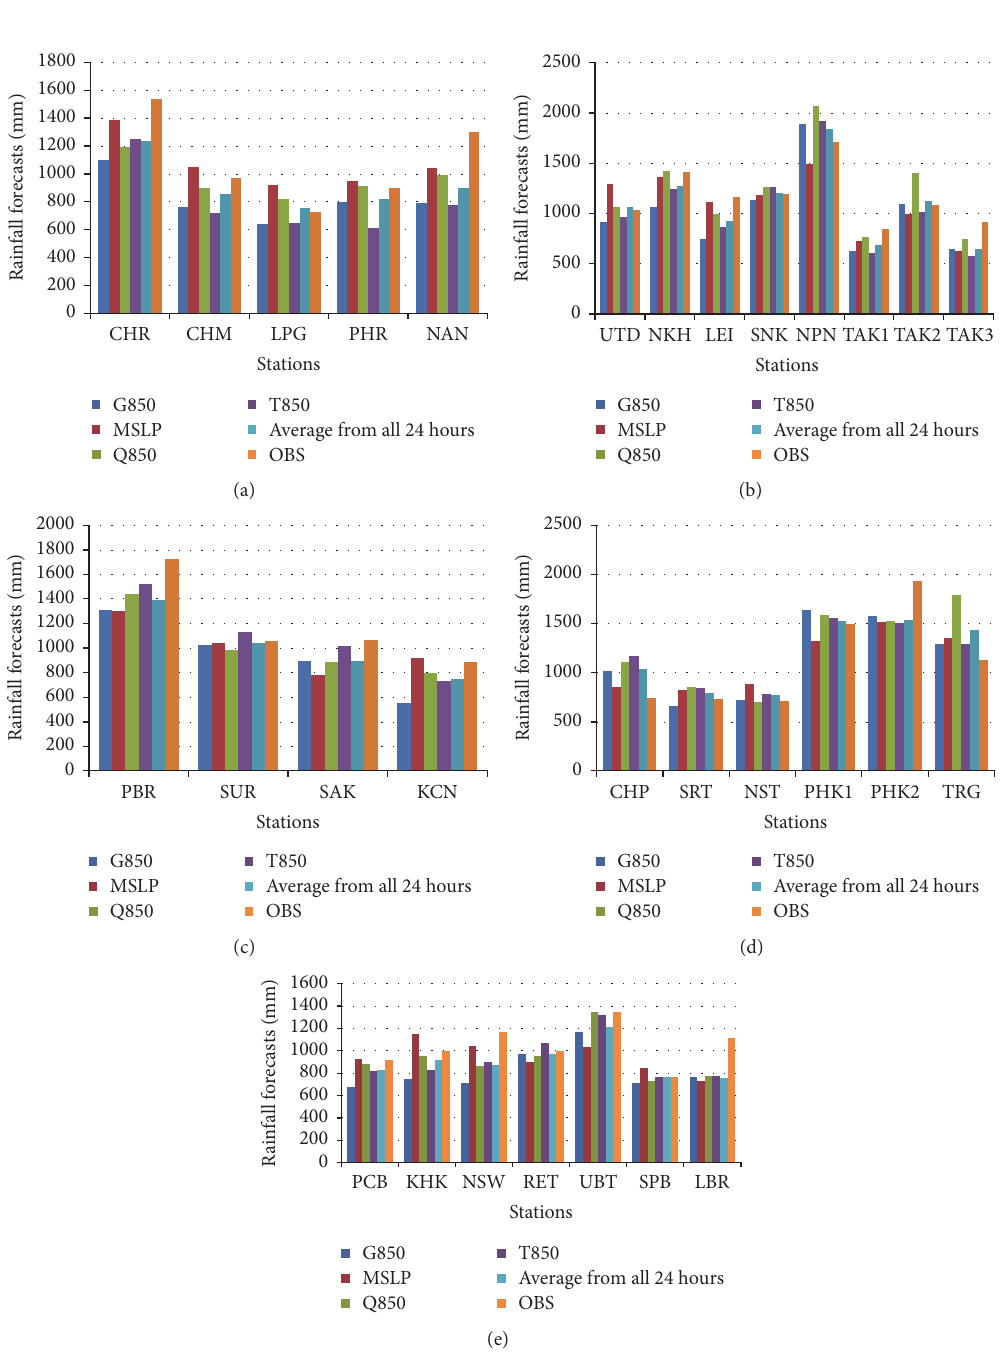
Figure 10: The histogram of the comparison between observed stations and simulations for four predictors, represented by an average from all 24 hours, mean sea level pressure, temperature, moisture, and geopotential height at 850 hPa of AM decomposition. This study shows five provinces: (a) northern, (b) northeast, (c) western, (d) southern, and (e)